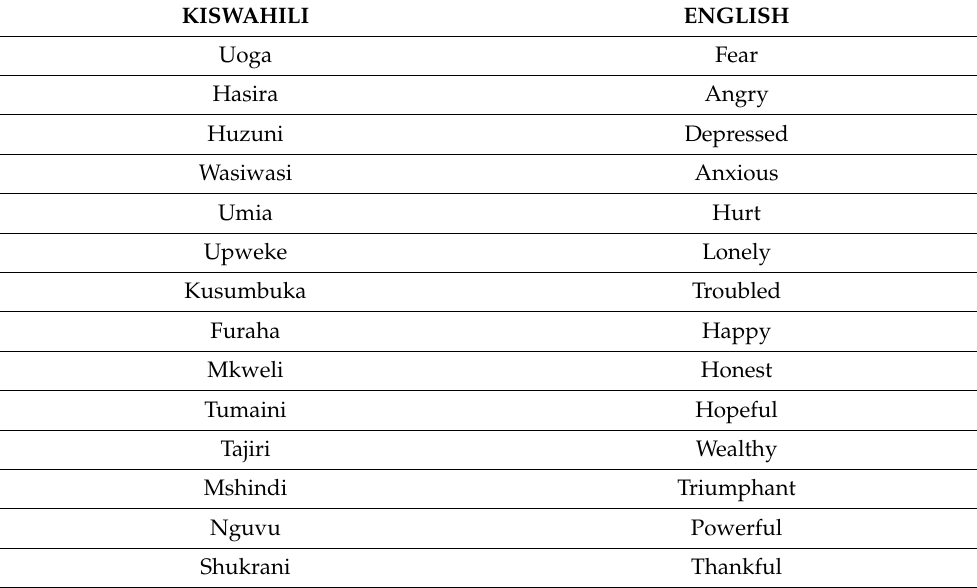
Table A1. Emotion words used in